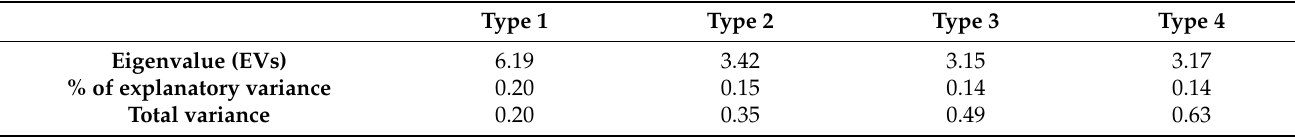
Table 3. Eigenvalue (EVs) and variance between types.